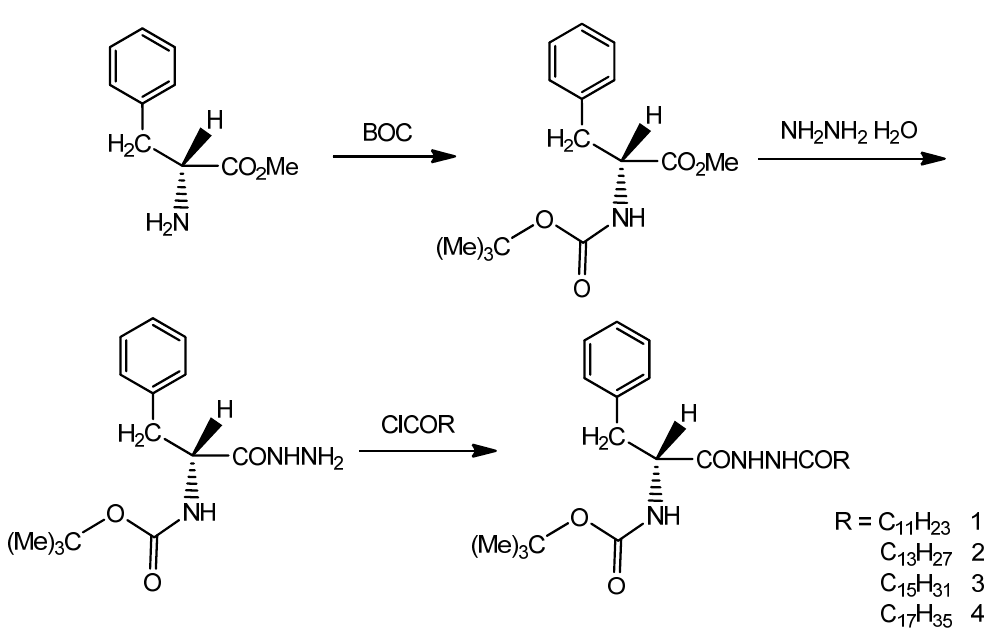
Scheme 1. Synthetic route of L-phenylalanine dihydrazide